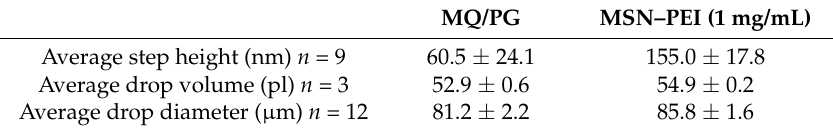
Figure 7. Confocal scanning laser microscope (CLSM) images of 5 mg/mL MSN–PEI and MSN–PEI–F15 suspensions printed with a resolution set at 150 dpi on ( A ) transparency and ( B ) HPMC films. Table 3. Average drop volume, diameter and step height of the MQ/PG ink and 1 mg/mL MSN–PEI suspension deposits on HPMC.